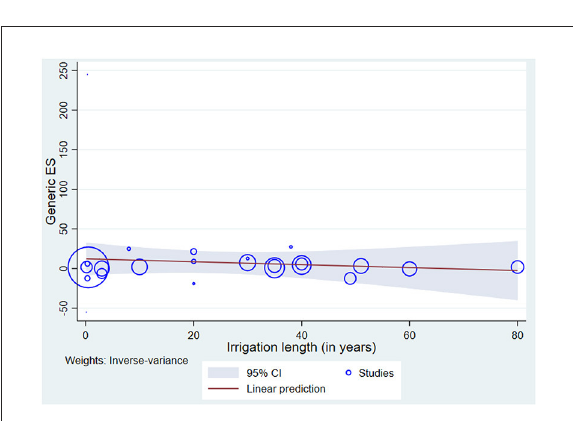
FIGURE6 Meta-regression bubble plot of Pb concentration in irrigated soil as a function of the duration of